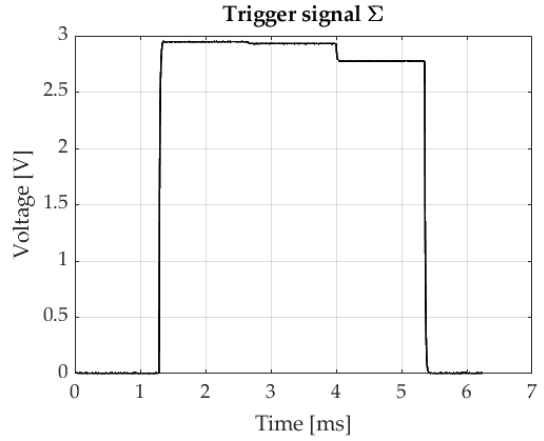
Figure 6. Trigger signal example.